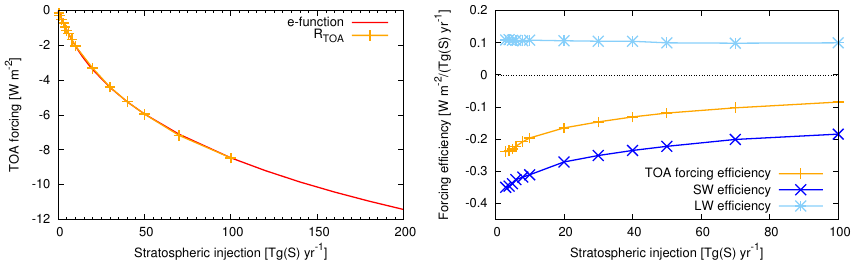
Figure 1. (Left) Top of the atmosphere (TOA) radiative fluxes (net shortwave plus net longwave, orange) for different injection rates (GeoX, Table 1) and exponential fit of TOA forcing (red) (Eq. 1). (Right) Forcing efficiency of TOA radiative forcing, forcing per injection [Wm − 2 ( Tg ( S ) yr − 1 ) − 1 ], for (cid:49)R TOA (orange), SW and LW radiation